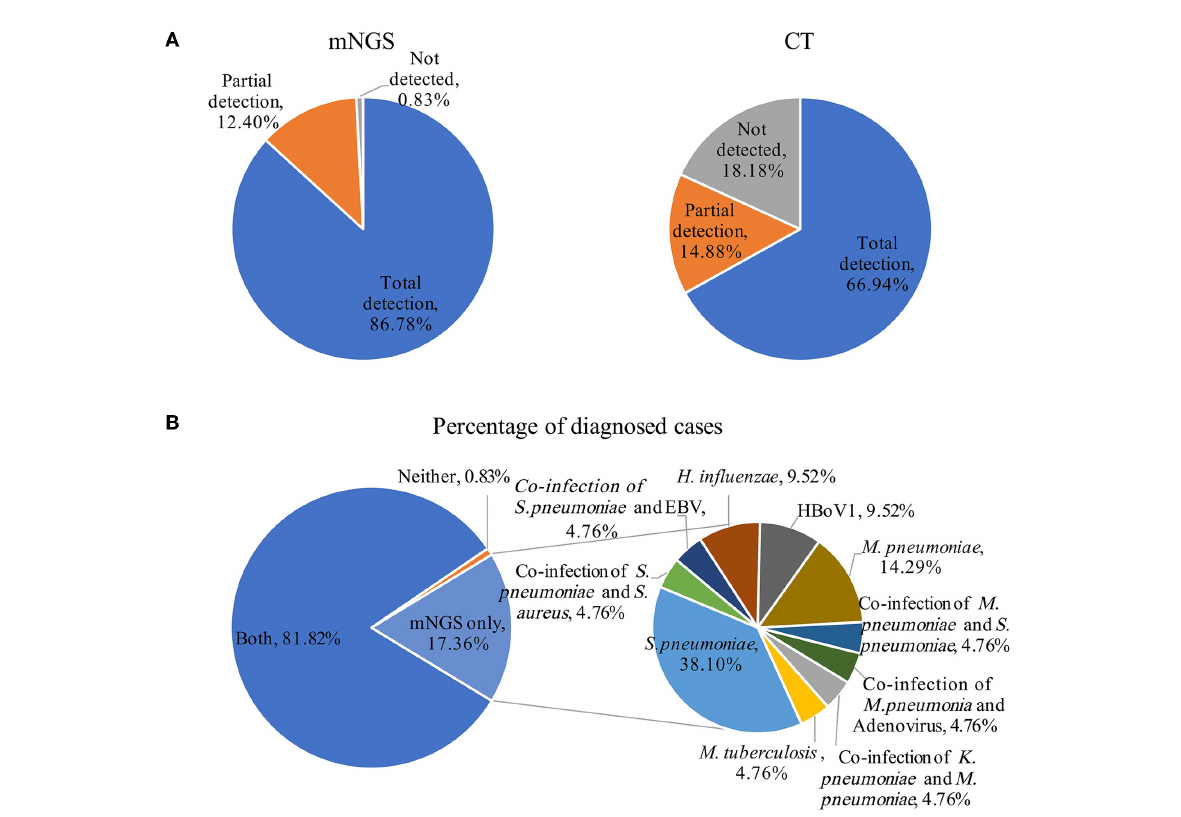
FIGURE2 Comparison of pathogens detection using the metagenomic next generation sequencing (mNGS) and conventional tests (CT) methods for the diagnosis of community-acquired pneumonia. (A) Using the final clinical diagnosis as references, the percentages of patients with complete detection, partial detection, and no pathogen detection using the mNGS and CT method. (B) The impact of mNGS in pathogen diagnosis, percentage of patients were diagnosed using both the mNGS and CT methods, neither and mNGS only (pie chart on the left), pathogens identified only using mNGS contribute to diagnosis (pie chart on the right). EBV, Epstein–Barr virus.